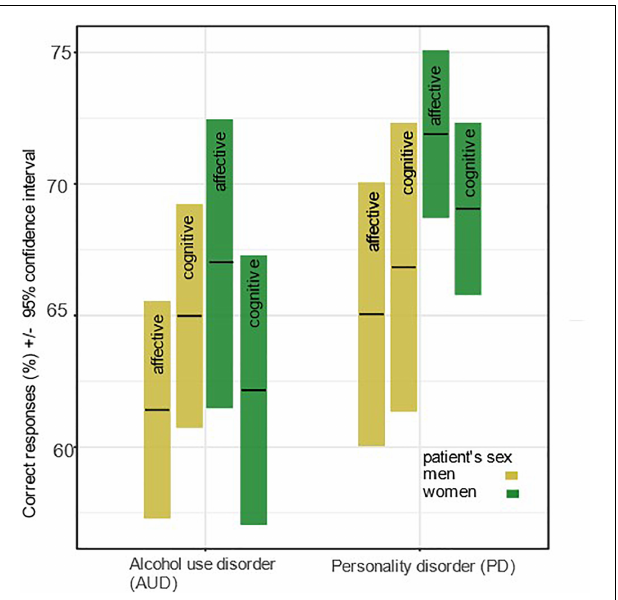
FIGURE 1 | Mean correct responses (%) and 95% confidence intervals for ToM performance by ToM facet, disorder, and participant’s